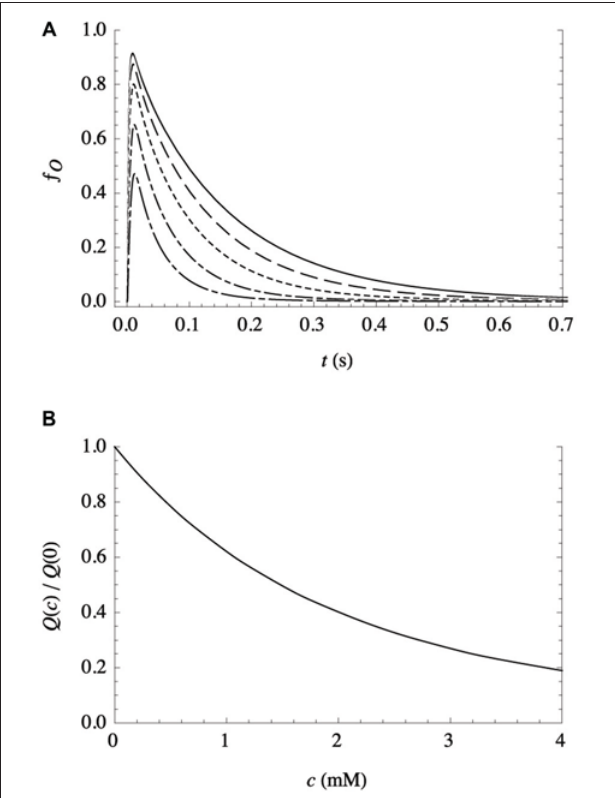
FIGURE 1 | Effect of a continuously present noncognate NT, at varying concentrations c , on the response of a patch of recombinant receptors to a short (10 ms) pulse of a saturating concentration of their NT agonist, as calculated from the kinetic model with parameter values as detailed in Lee et al. (2015). (A) Representative traces, expressed as the fraction of receptors in the conducting state vs . time, for c = 0 mM (solid line), 0.5 mM (dashed line), 1.2 mM (dotted line), 2.4 mM (dash-dotted line), and 4.0 mM (long dash-dotted line). (B) Total ion flux (i.e., the integrated current) relative to ion flux in the absence of noncognate NT, as a function of c